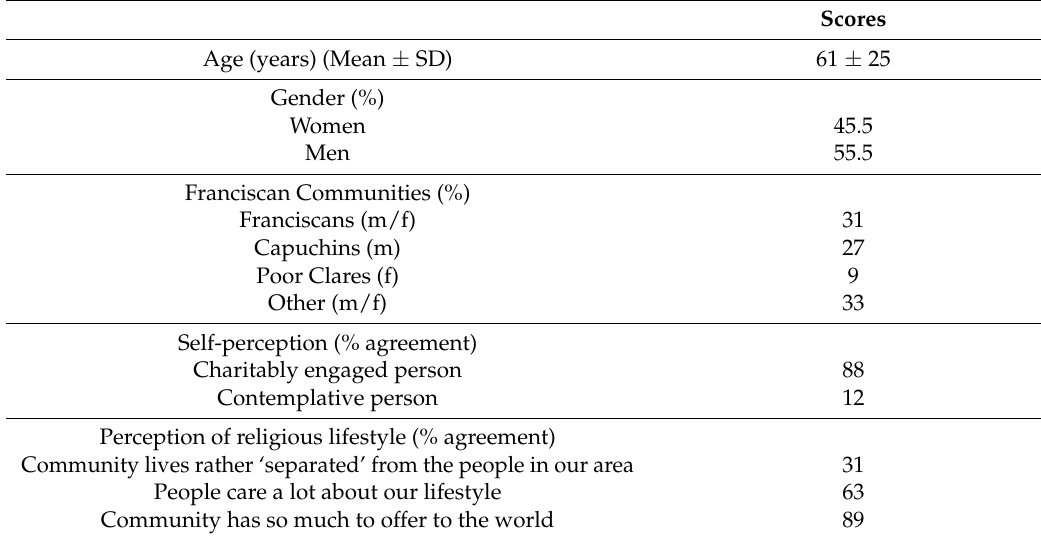
Table 2. Description of the sample ( N = 388).